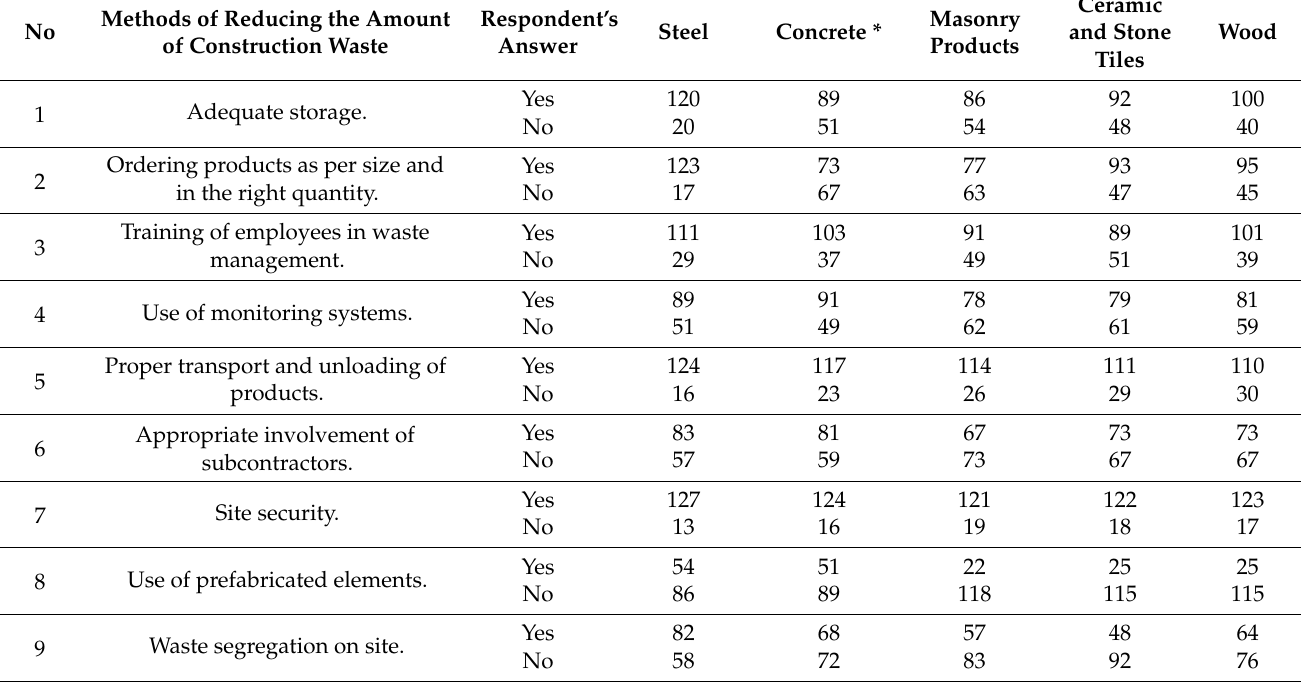
Table 1. The application of construction waste reduction methods for the five tested building